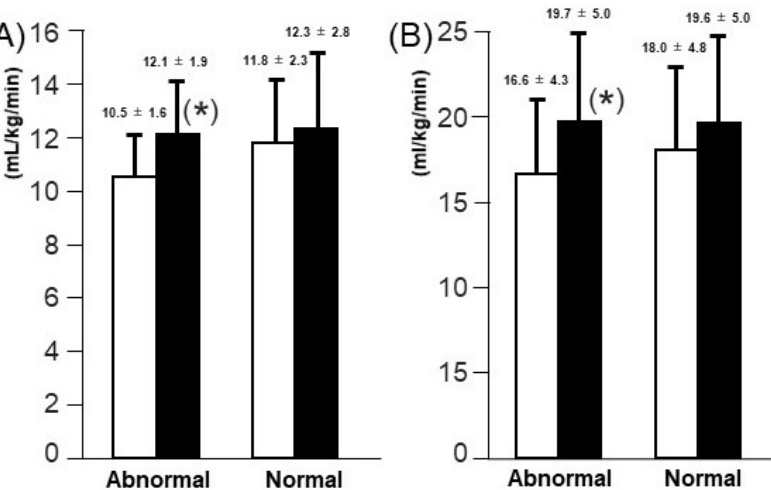
Figure 3. Changes in AT ( A ) and PVO2 ( B ) following the 5-month cardiac rehabilitation in the nor- mal and abnormal TAPSE groups. * p < 0.05 compared to baseline. Open bars, baseline; solid bars, 5-month